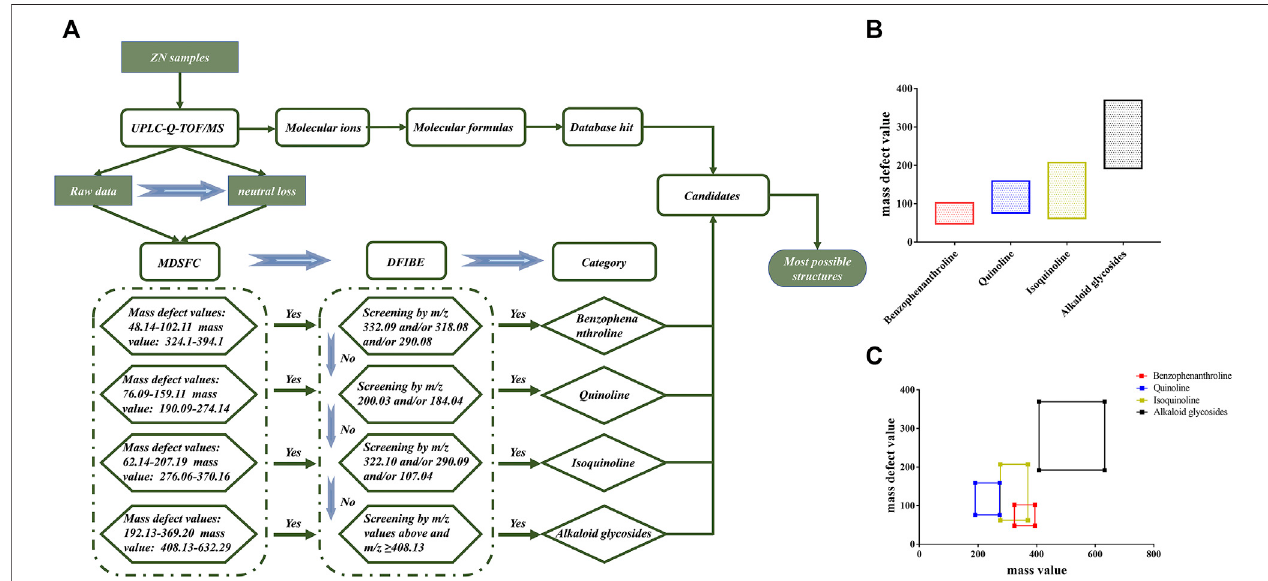
FIGURE 2 | The structure-diagnostic ion-oriented network (A) . The mass defect ranges of different types of alkaloids in ZN (B) ; the correlations between the mass ranges and mass shifts of the basic skeletons of ZN alkaloids (C) . MDFSC, mass defect fi ltering-based structure classi fi cation; DFIBE, diagnostic fragment-ion-based